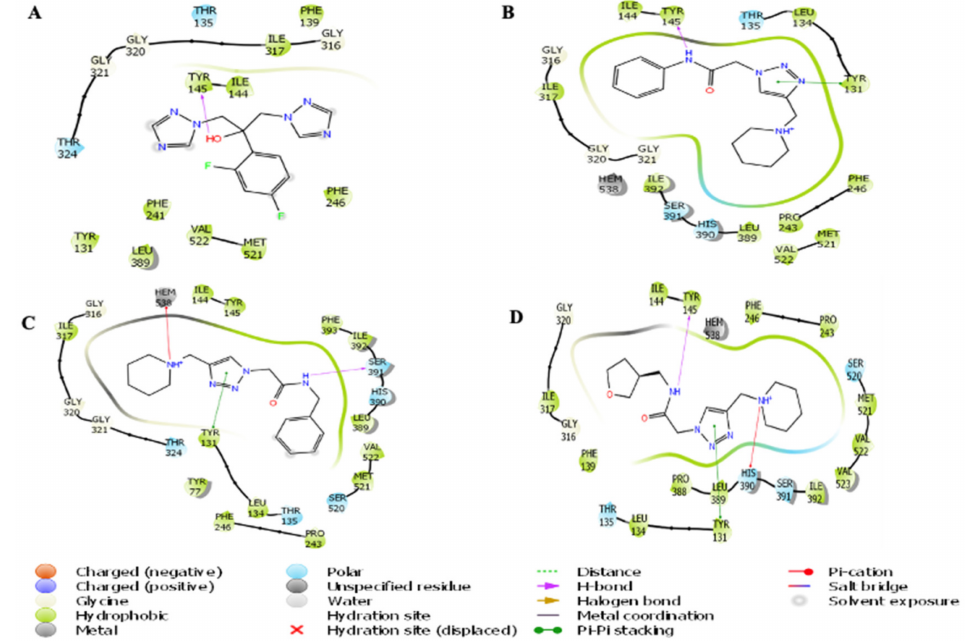
Figure 2. Docked poses of LDM with the studied inhibitors. Molecular interaction of ( A ) Fluconazole and ( B ) pta1, ( C ) pta2, and ( D ) pta3 with the active site of LDM